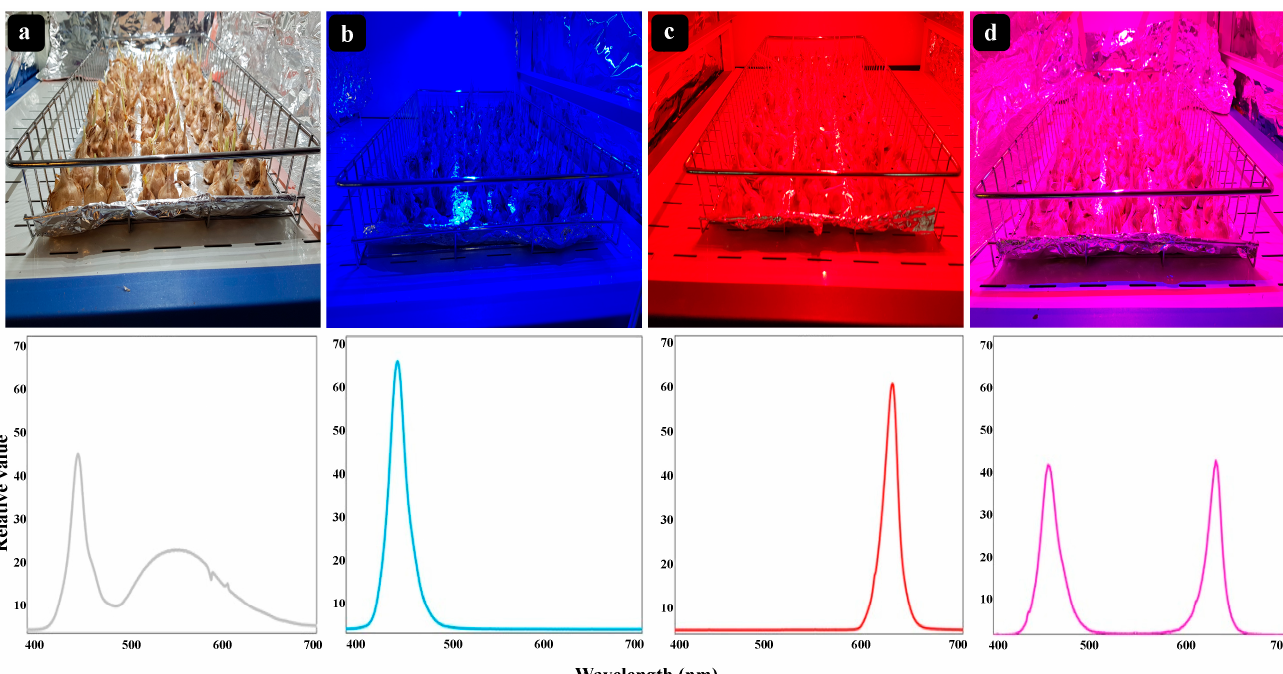
Figure 1. The lighting conditions together with the relative spectral distribution of each lighting treatment. Four lighting treatments are illustrated: White ( a ), monochromatic blue ( b ), monochromatic red ( c ), and a combination of blue and red lights ( d ). The light treatments were separated with a panel wall to segregate light regimes.